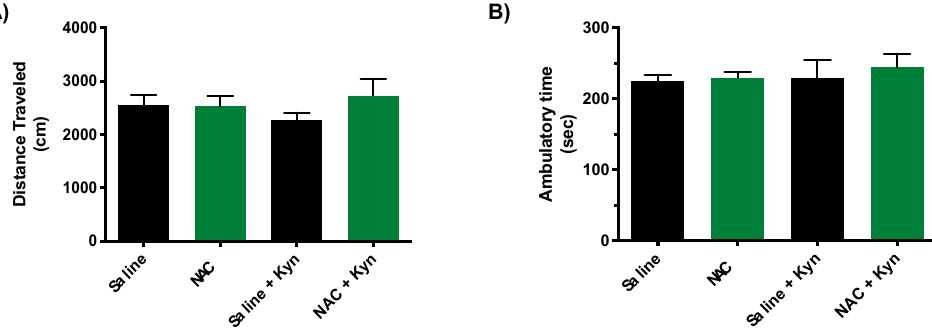
Figure 5. Locomotor activity in mice following the memory test on Day 7 (cf. Figure 4A). Distance traveled and ambulatory time are showed in ( A ) and ( B ), respectively. See Materials and Methods for experimental details. Data are the mean ± SEM ( n = 5 per group). No significant group differences were observed ( p > 0.05, Mann–Whitney test).